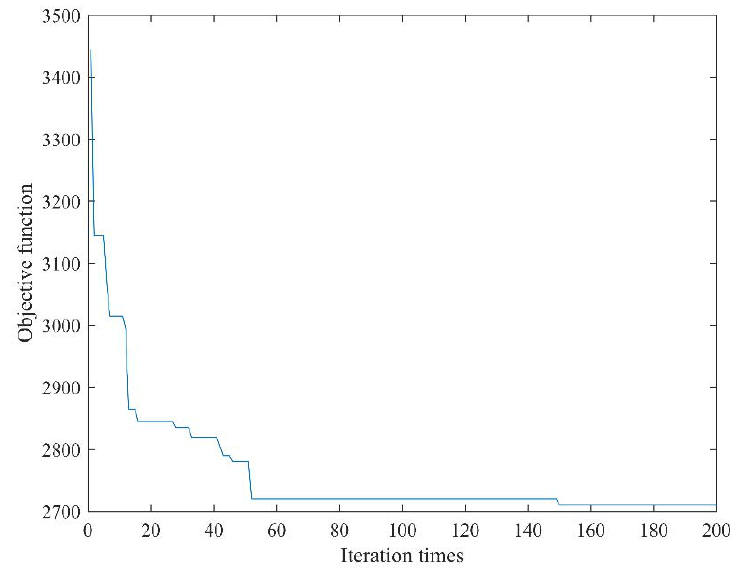
Figure 6. Best feasible solutions for multi ‐ stage unrelated parallel machine scheduling problems from ILCA.